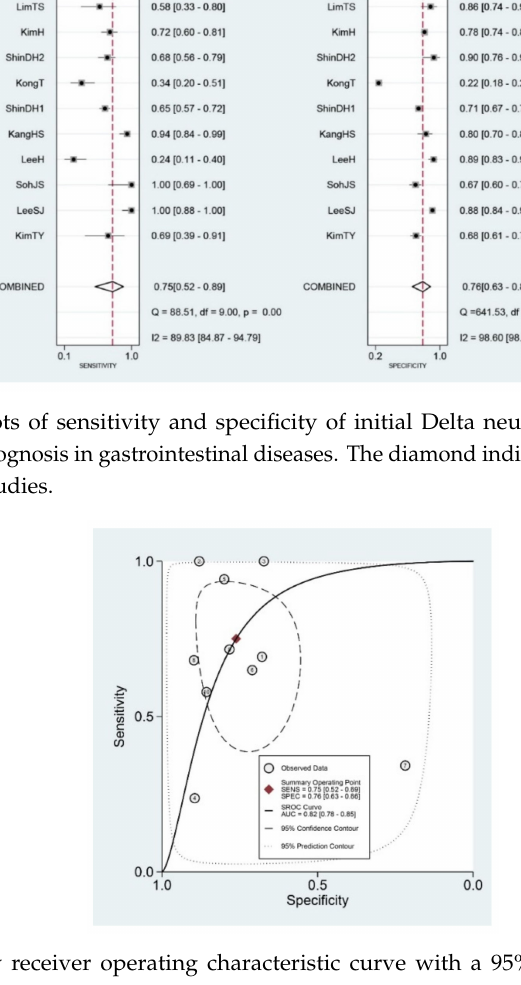
Figure 4. Summary receiver operating characteristic curve with a 95% confidence region and a prediction region for the prediction of poor prognosis in gastrointestinal diseases. SENS, sensitivity; SPEC, specificity; SROC, summary receiver operating characteristic; AUC, area under the